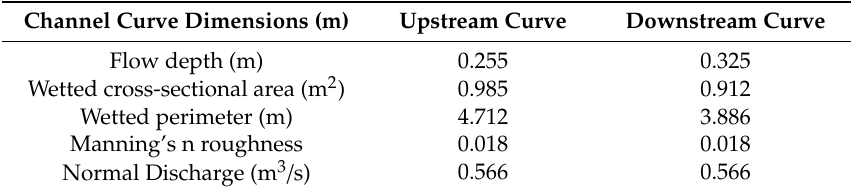
Table A4. Summary of CSU physical model hydraulic characteristics